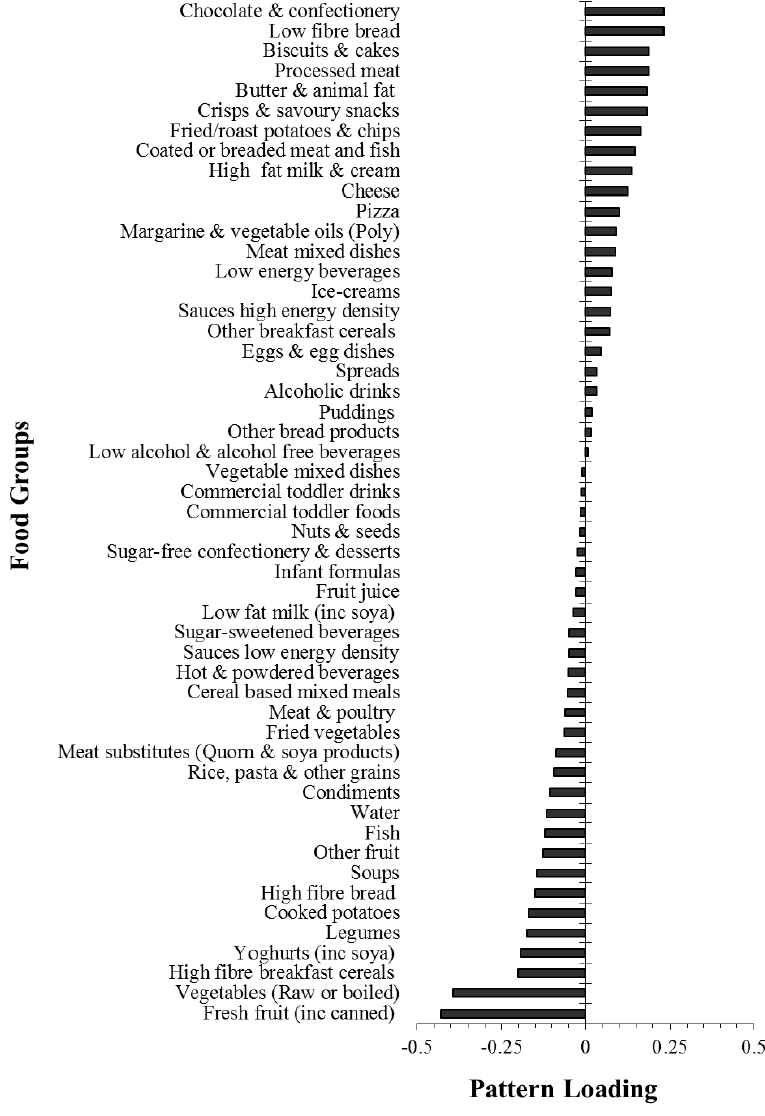
Figure 1. Dietary pattern loadings for each food group in children and adults.